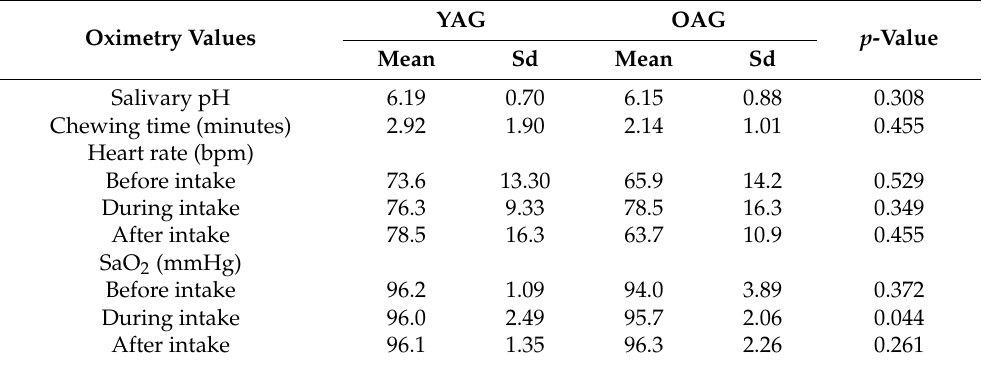
Table 5. Salivary pH, chewing time, heart rate and SaO 2 in adults with Down syndrome as a function of